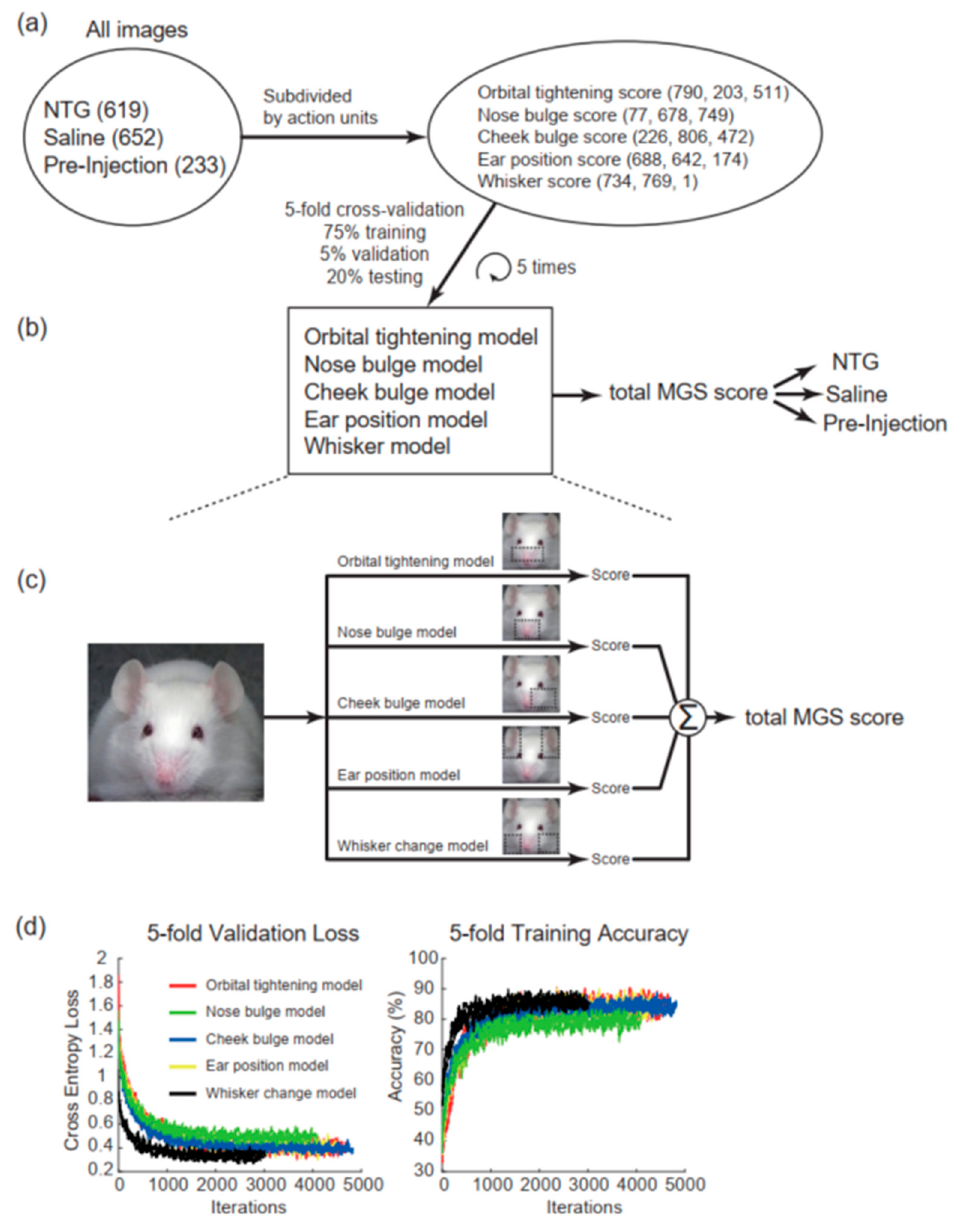
Figure 2. Preparation of the dataset and the architecture of the DeepMGS. ( a ) All images collected from NTG, saline, and preinjection conditions (values in brackets indicate numbers of images) were annotated by the experienced human scorer and subdivided into five MGS action units. Each image was scored using the MGS by the experienced scorer, and the results were used as the ground truth (values in brackets indicate numbers of images annotated with scores of 0, 1, and 2). ( b ) Among the full dataset, 1127 images (75%) were assigned as the training set, 76 images (5%) as the validation set, and 301 images (20%) as the testing set. The five-fold cross-validation process of model training was repeated five times, yielding the estimates of the model’s predictive performance. The DeepMGS contains five classification models to predict the five action unit scores. ( c ) The predicted action unit scores were summed to yield the predicted total MGS score. ( d ) The five-fold validation loss ( left panel) and training accuracy ( right panel). The x -axes represent the iteration number, and the y -axes in the two panels represent the cross-entropy loss and training accuracy, respectively. The five action units are presented with different colors in the diagram.